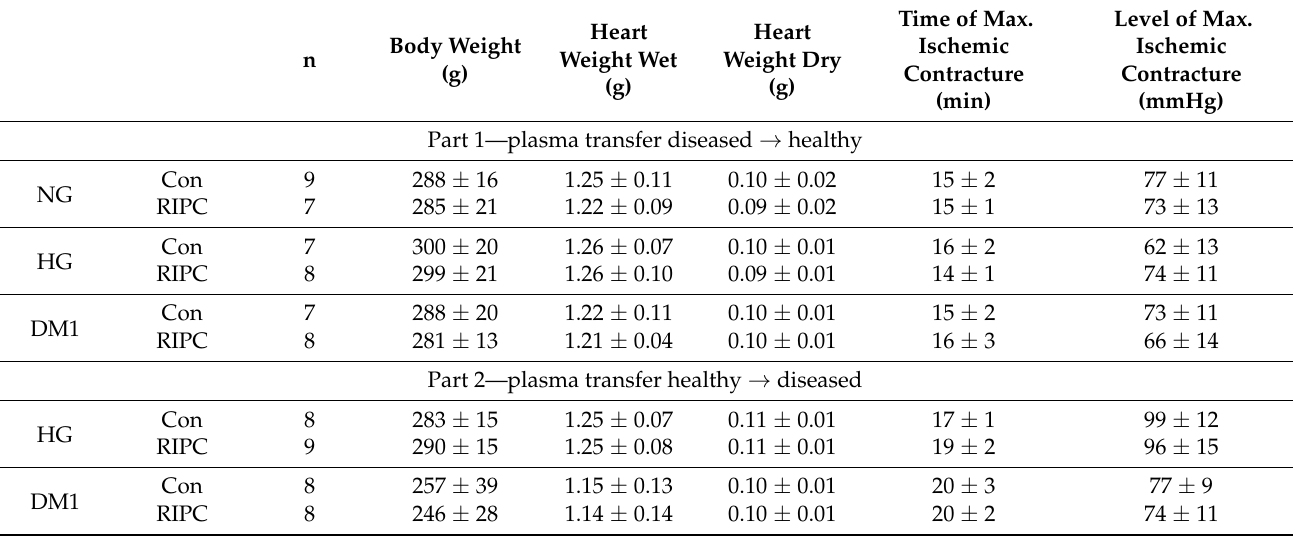
Table 1. Weights and ischemic